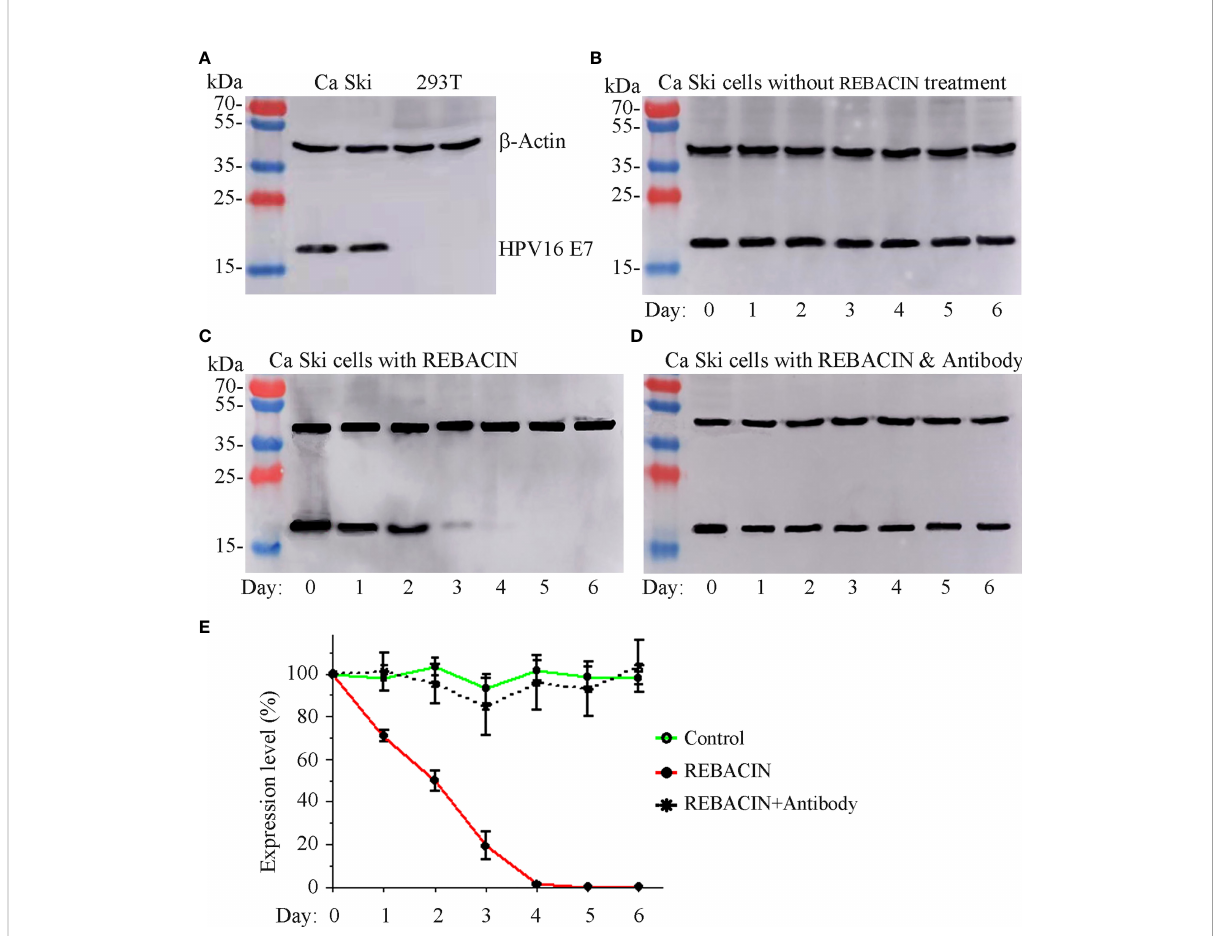
FIGURE 3 Effect of REBACIN ® on the expression of HPV16 E7. Ca Ski or 293T cells in 6-well plate were treated or not treated by 50 m g/ml REBACIN ® for up to 6 days. The expression of b -actin and HPV16 E7 in different cell lines was detected by western-blot in (A) , and their expression levels in each well every 24 hours under different conditions were shown in (B – D) , respectively. Representative images were shown in (A – D) , and the relative quantitative data from (B – D) were analyzed and shown in (E) , which the expression level at 0 day was set as 100%. Data show mean ± SEM of three independent experiments. REBACIN ® versus control: p < 0.001 in (E)